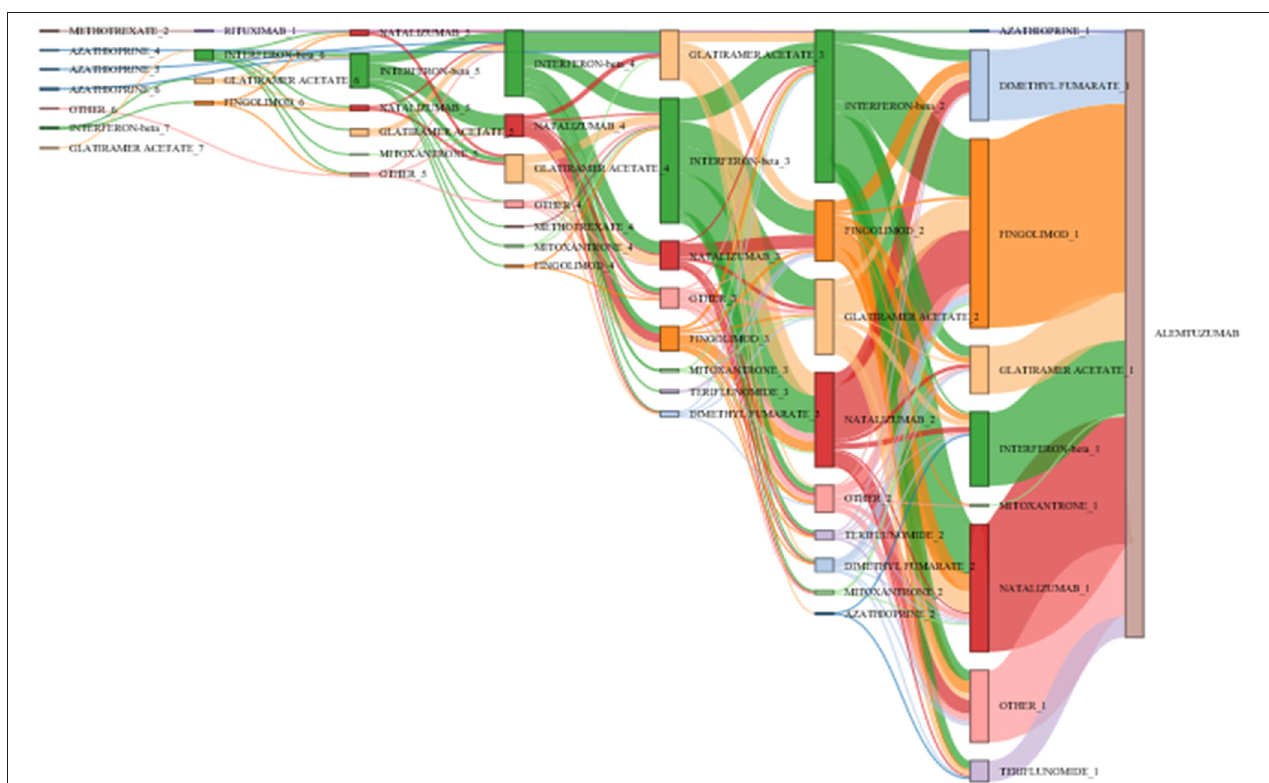
FIGURE 5 | Pathways of disease-modifying treatments (DMTs) before final switch to alemtuzumab. The figure illustrates the various treatment pathways as in Figure 4 . By moving the cursor over the connecting ribbons, the respective number of patients treated with the previous DMT are indicated. The number following the DMT name indicates the position in the treatment sequence. The bars can be moved vertically to change the view of the Sankey